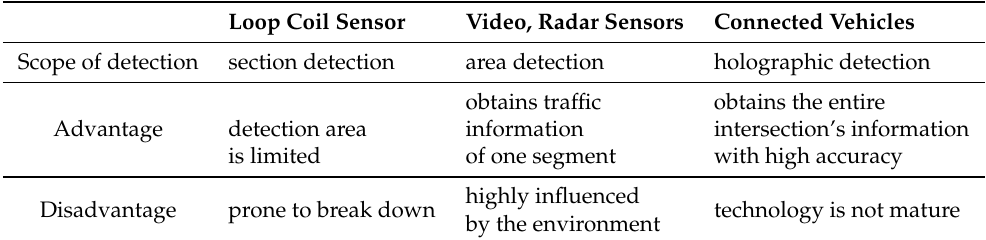
Table 2. Comparison of sensors, detailing the range of applications and advantages and disadvantages of different